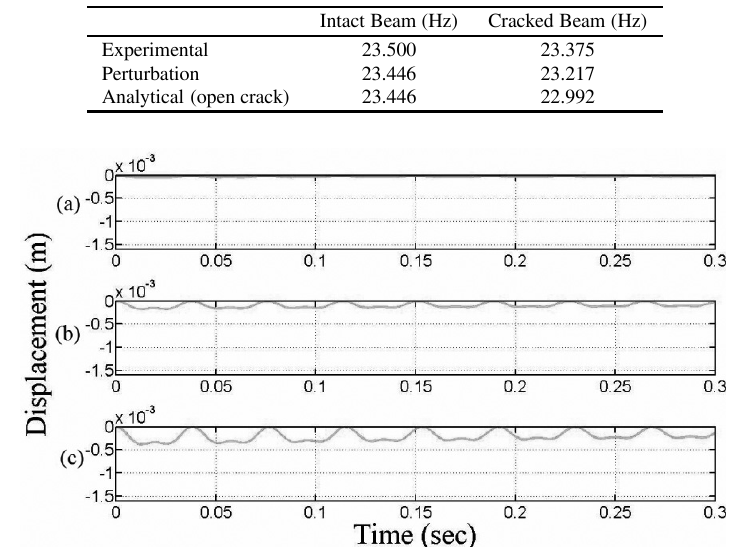
Fig. 7. Correction term for α = 0.5 and (a) β = 0.3 (b) β = 0.6 (c) β = 0.9.